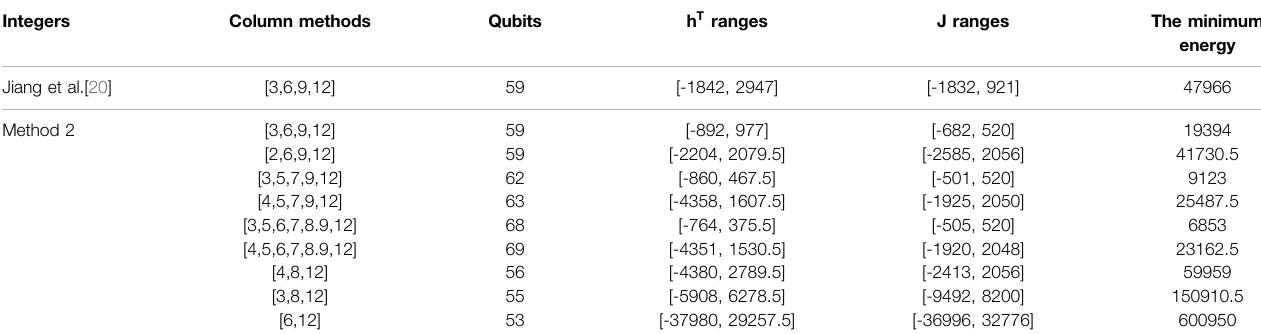
TABLE 6 | Different methods of factoring the integer 59989.